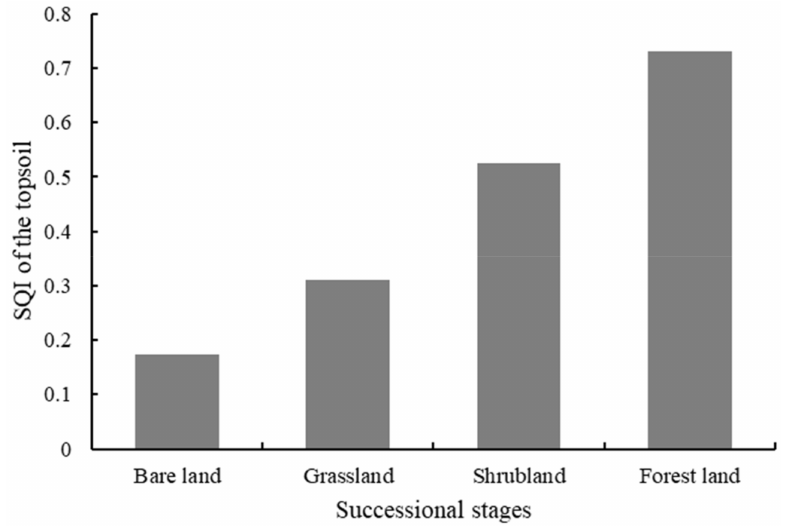
Figure 5. Soil quality index of vegetation types along the successional